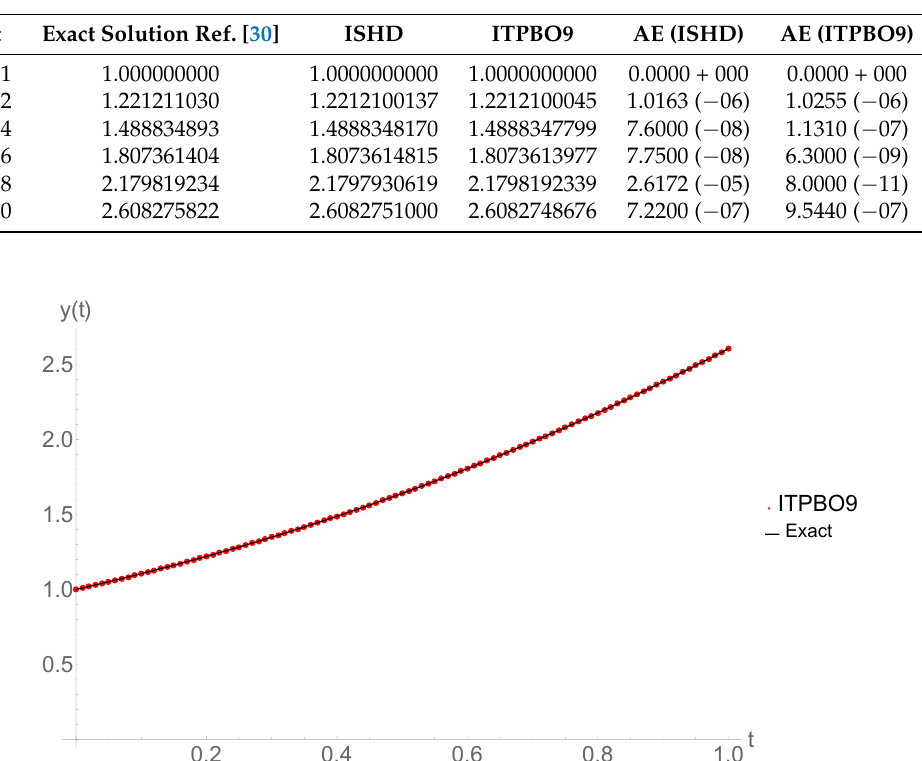
Table 9. Numerical findings for solving Problem (27) with µ = 2, h = 0.01.